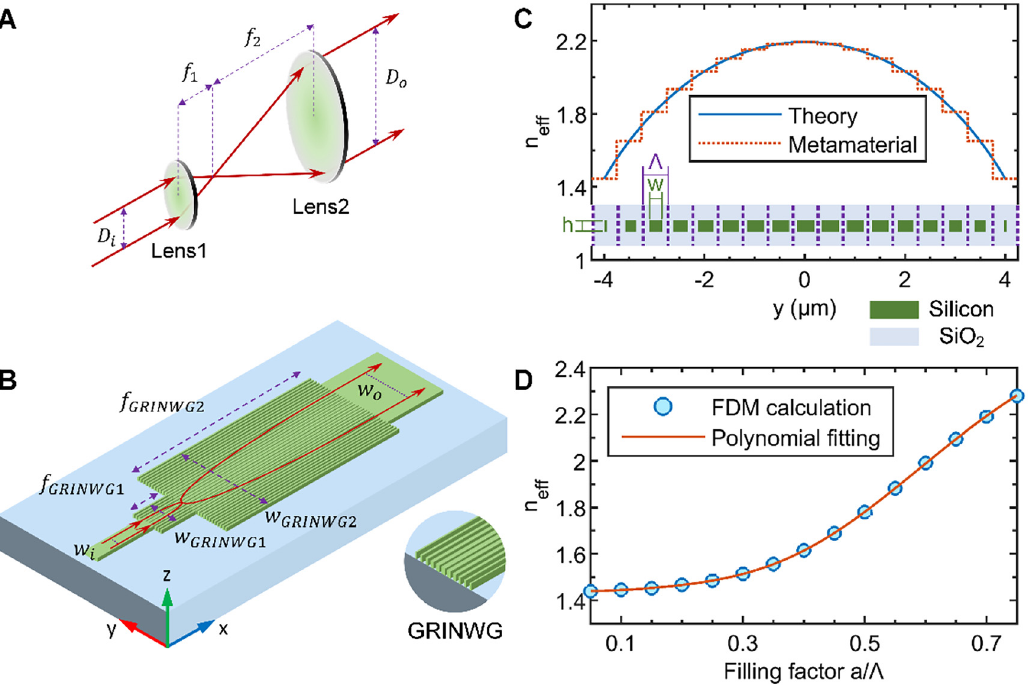
Figure 1: Schematic and the design of the proposed AM-SSC. (A) Beam expander in bulk optics. (B) On-chip AM-SSC consisting of two metamaterial-based GRINWGs. (C) Cross-section design of the GRINWG. (D) Element design library for metamaterial. SSCs, spot size converters; GRINWG, graded-index waveguide; AM, arbitrary mode.